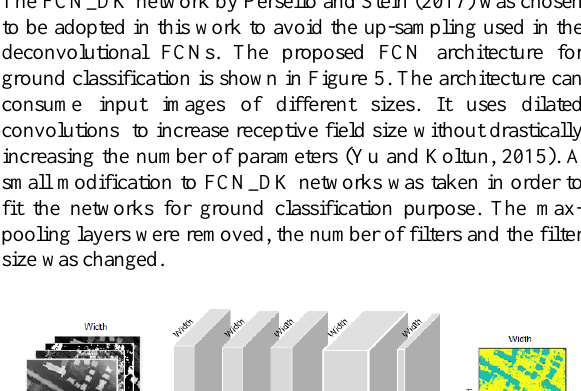
Figure 4. An illustration of CNN architecture LeNet-5 (Le Cunn et al., 1998)